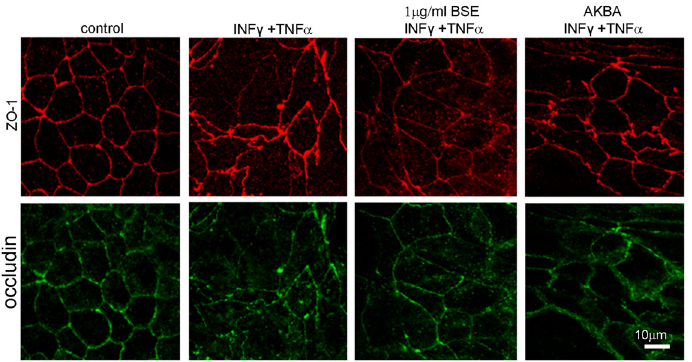
Fig 6. BSE and AKBA ameliorate alterations induced by INF- γ +TNF- α on zonula occludens (ZO1) and occludin TJ proteins in Caco-2 cell monolayers. Double immunostaining showing the distribution of ZO-1 (red) and occludin (green). Images were collected by confocal laser-scanning microscope and are representative of 3 independent experiments. Scale bar = 10 μ m.